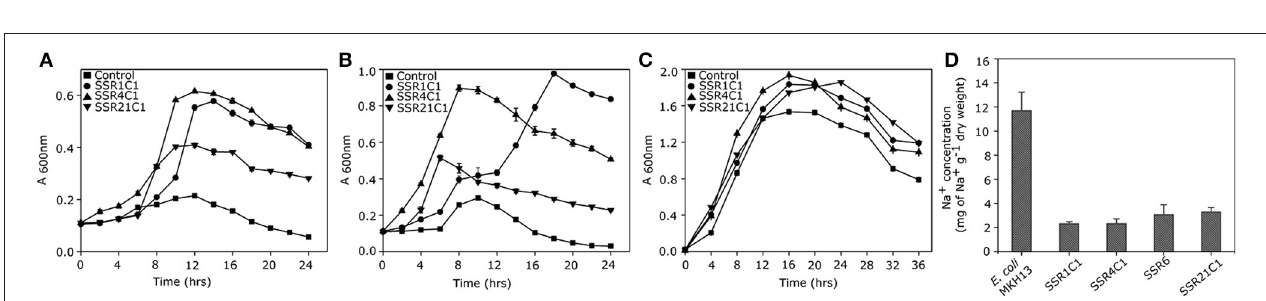
FIGURE 4 | Transposon insertion map of pSSR1 , pSSR4 , pSSR6, and pSSR21. T indicates a transposon insertion site identified within transposon positive mutants (no effect on plasmid derived osmotolerance property) while ↑ indicate transposon insertion site identified within transposon negative mutants (loss of plasmid derived osmotolerance property).